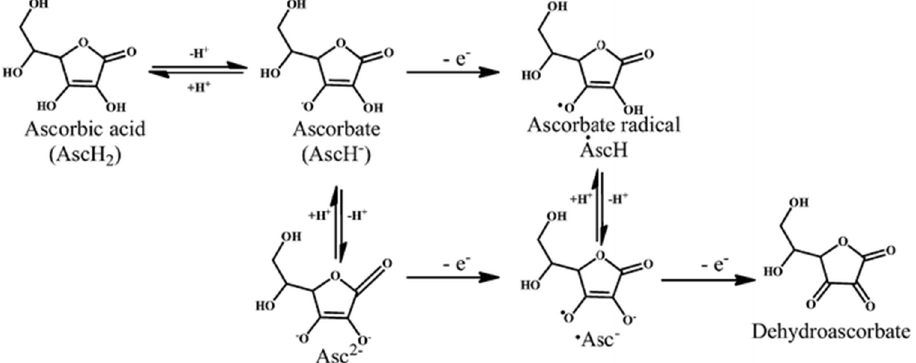
Figure 12. The proposed radical scavenging activity of ascorbic acid (adapted from Nimse and Pal, 2015 [143]—published by The Royal Society of